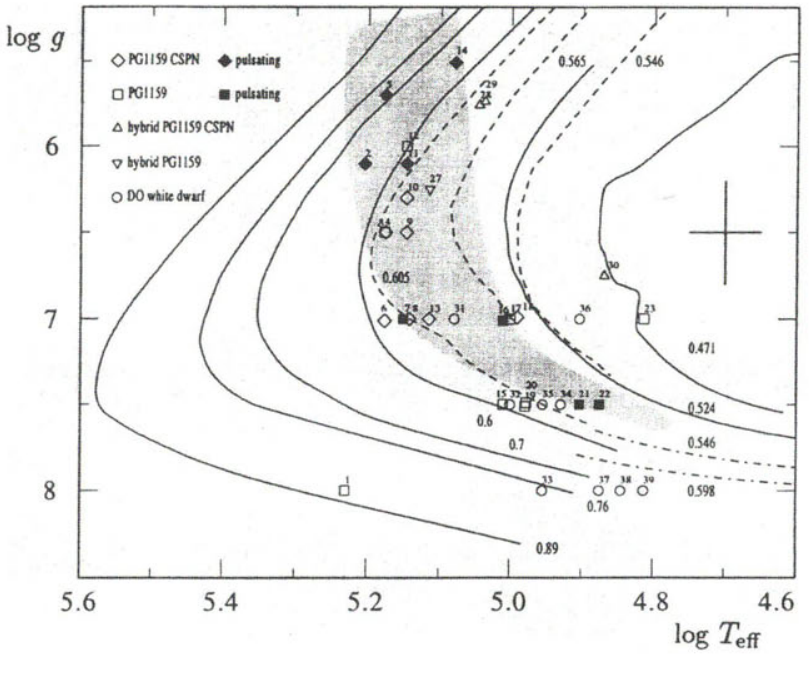
Fig. 1. Location of the GW Vir instability strip (shaded region), comprising the pulsating PG 1159 stars (filled symbols). Evolutionary tracks are labeled with the respective stellar mass. A typical error bar is shown. For object identification and other details see Dreizler et al.